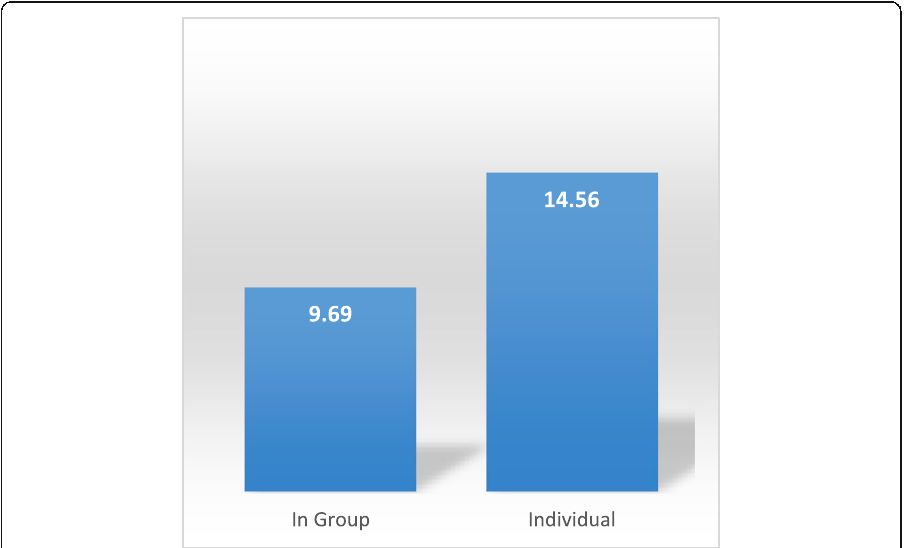
Fig. 3 Means on posttest of speech acts by